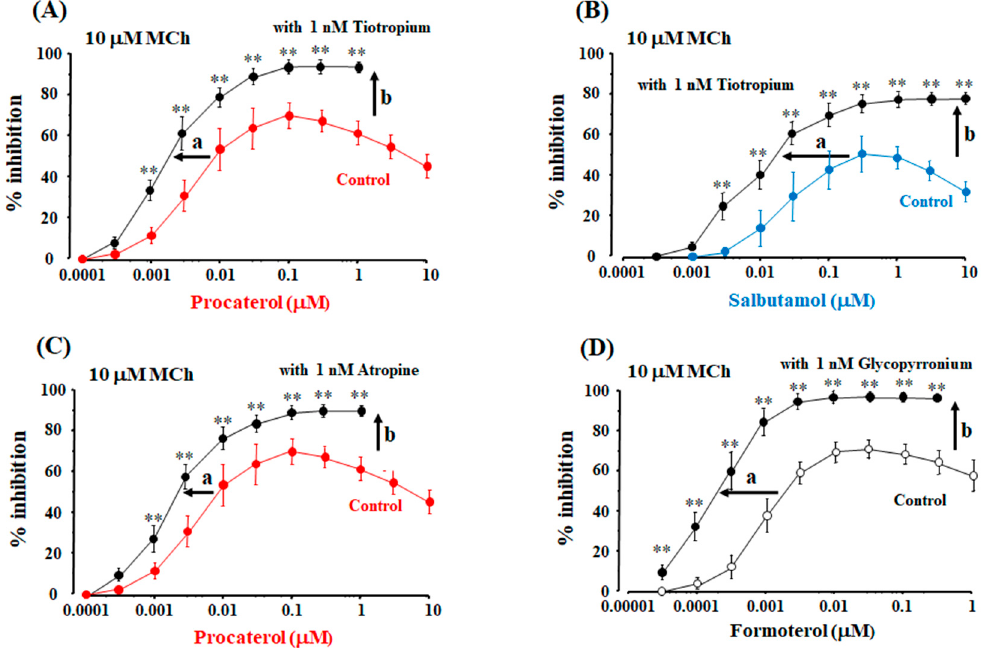
Figure 5. Synergistic effects of a combination of β 2 -adrenergic receptor agonists with muscarinic receptor antagonists against muscarinic contraction via allosteric effects (affinity and efficacy modulation). Concentration-inhibition curves for procaterol ( A ) and salbutamol ( B ) against MCh (10 μ M)-induced contraction in the absence and presence of tiotropium (1 nM); ( C ) Concentration-inhibition curves for procaterol against MCh (10 μ M)-induced contraction in the absence and presence of atropine (1 nM); ( D ) Concentration-inhibition curves for formoterol against MCh (10 μ M)-induced contraction in the absence and presence of glycopyrronium (1 nM). MCh: methacholine, ( a ): affinity, ( b ): efficacy, **: p < 0.01. Table 2. Pharmacological characteristics of β 2 -adrenergic receptor agonists.